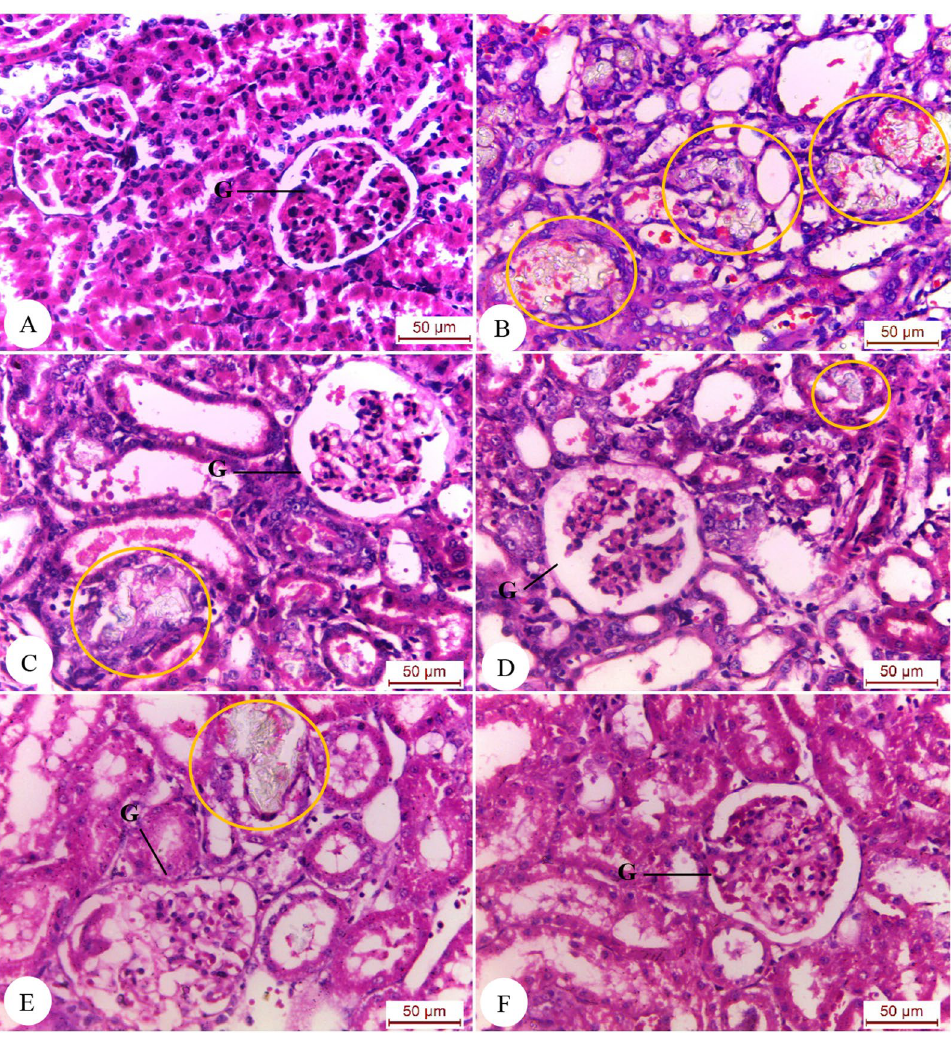
Fig. 5 Photomicrograph of kidney sections of rats in prophylactic regimen (H&E). A Control rats showing normal glomeruli (G) and tubular renal structure. B Urolithiatic rats showing multiple crystals deposition (yellow circle). C , D Urolithiatic rats treated with LACTN (500 mg/kg b.wt) showing low crystal deposits. E , F Urolithiatic rats treated with cystone (750 mg/kg b.wt) showing more or less drop in crystal deposition